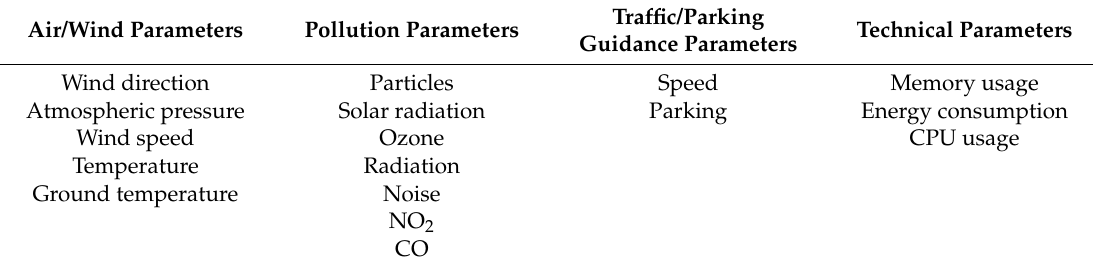
Table 2. Parameters